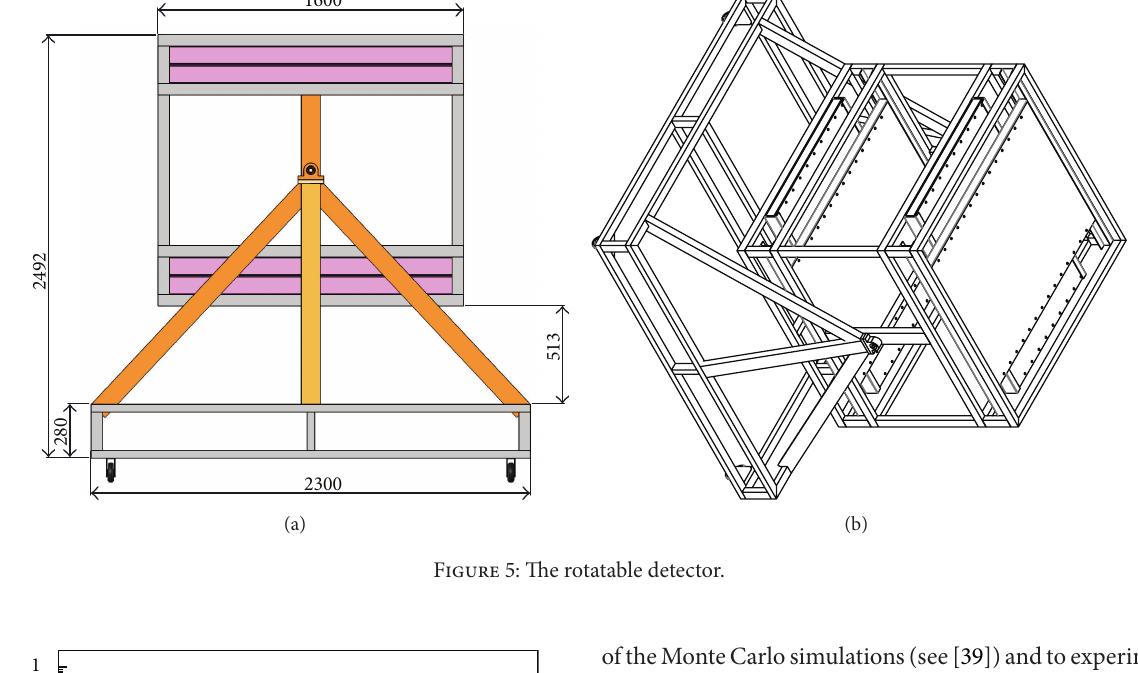
Figure 5: The rotatable detector.